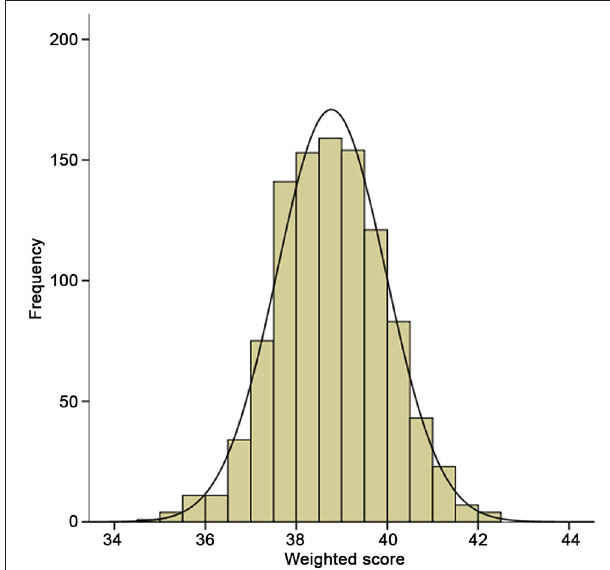
FIGURE 2 | Distribution of integer risk score for all 998 HF patients. The distribution shows a nearly bell-shaped curve, ranging from 34.82 to 42.23 points with a median value of 38.78.